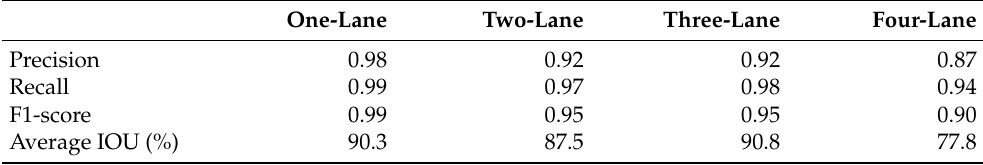
Table 9. Performance of the VT_LP